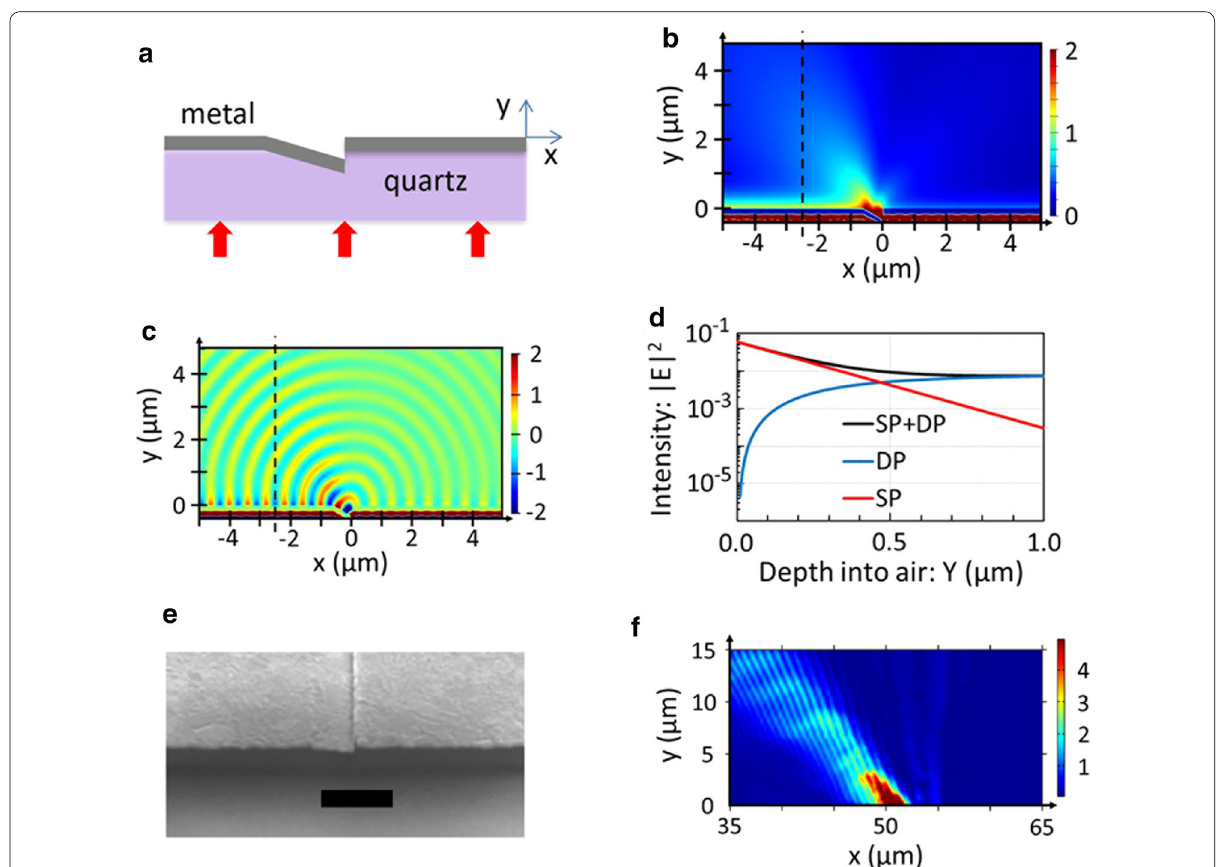
Fig. 2 Transmission through a tilted nanoaperture. a Schematic cross-section of a tilted nanoslit formed in a metal film. A 633-nm TM-polarized light is incident from the bottom side. The transmission patterns calculated by FDTD simulation: b the distribution of magnetic field amplitude | H z |; c a snapshot image of magnetic field H z . Circular wavefronts emanate from the nanoslit aperture with tilted peak-intensity orientation. d The field intensity distribution scanned along the normal direction at x 2.5 µm (dashed). The total field (black) is decomposed into two parts: = − surface-plasmon field (SP, red) and free-space propagating component (DP, blue). e SEM image of a tilted nanoslit aperture formed in a Cr film (100- to 140-nm thick). Scale bar, 1 µm. f A beam profile measured by scanning an NSOM